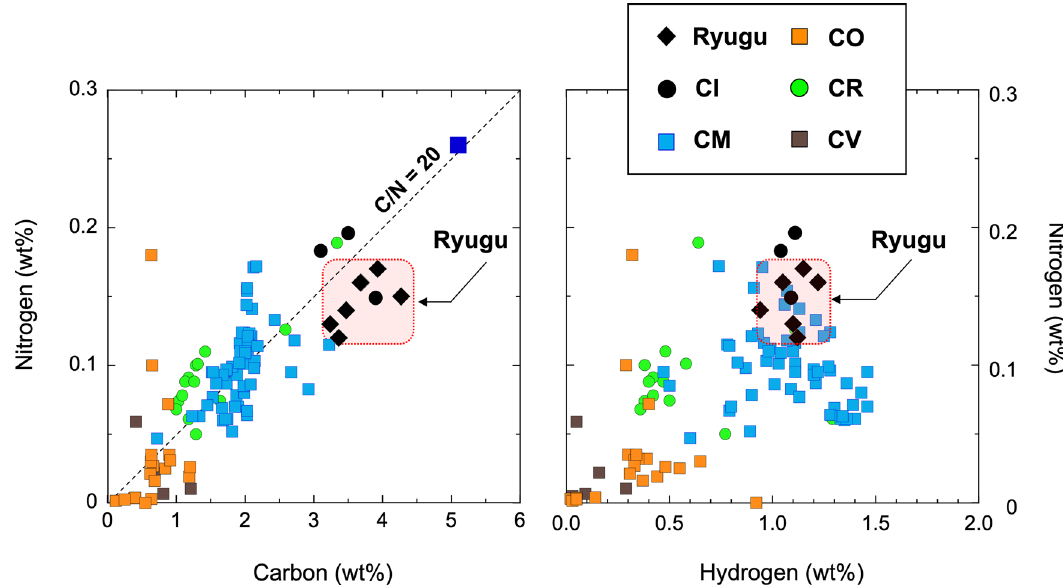
Fig. 2 | Elemental compositions ofthe Ryugu samples. The elemental pro fi les of A0106(i.e.,1sttouchdownsite)andC0107(i.e.,2ndtouchdownsite)forcarbon(C, wt%), nitrogen (N, wt%), and hydrogen (H, wt%). with those of reference carbo- naceouschondrites(CI,CM,CO,CR,andCV;Naraokaetal. 6 andthesupplementary